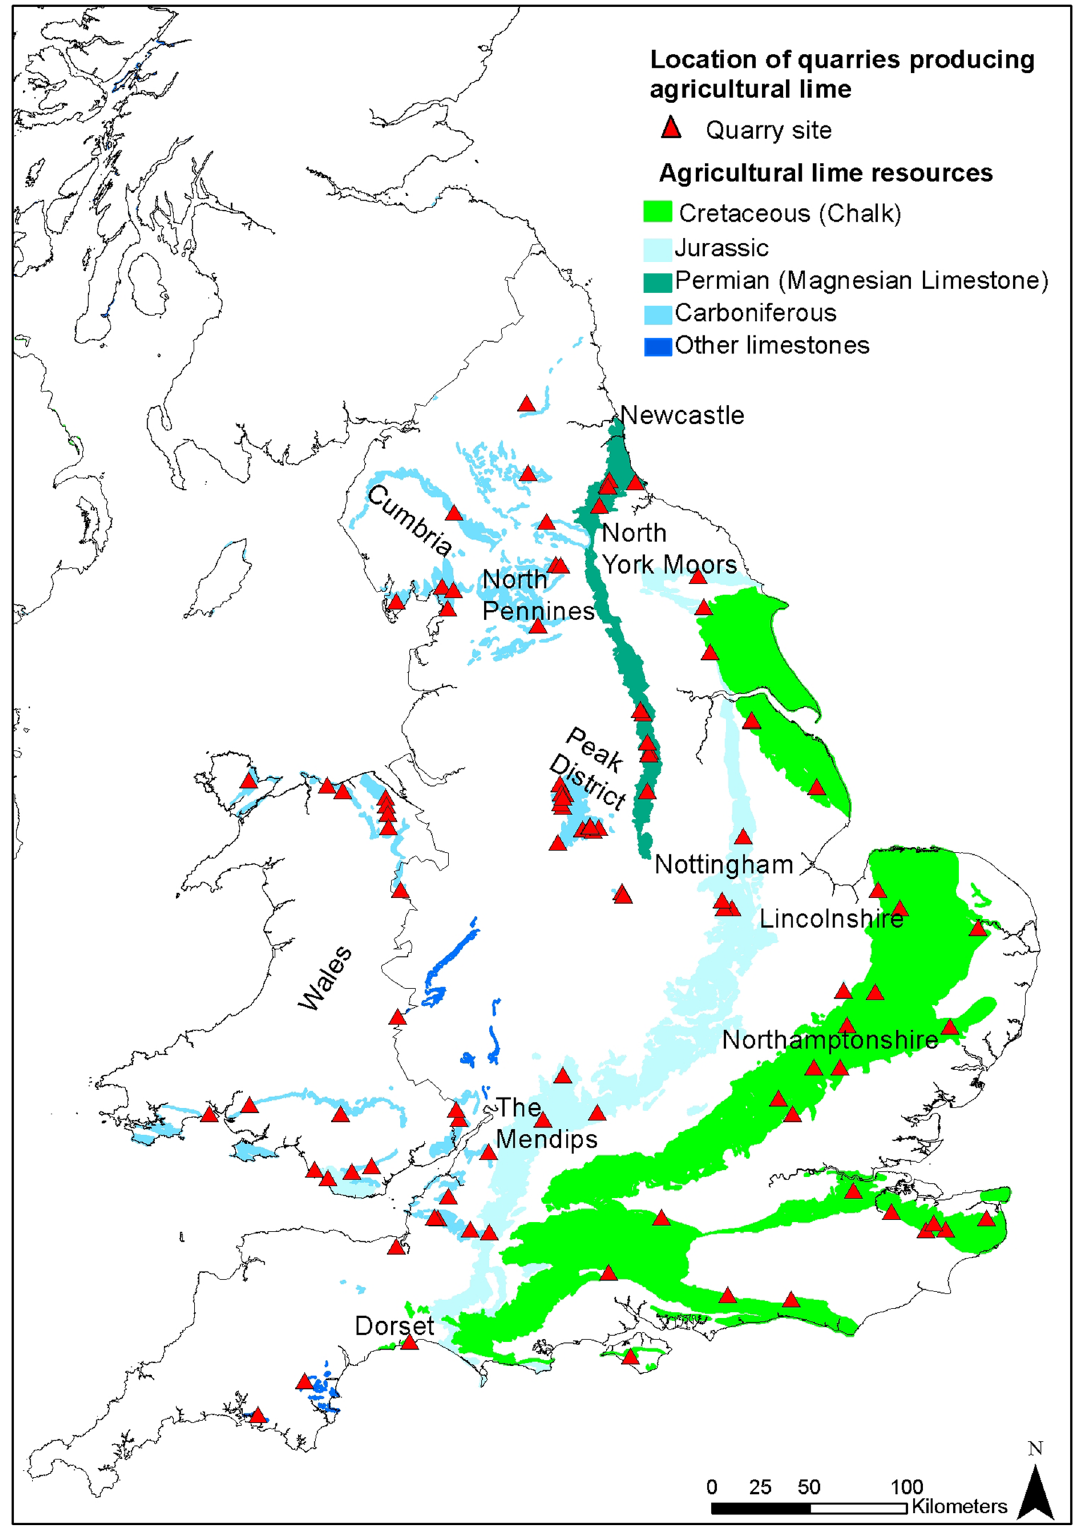
Figure 2. The outcrop of the major carbonate rocks of England and Wales and the location of agricultural lime quarries. Adapted from BGS Geology 50K 34 . Created using ArcMap 10.7.1, ESRI,